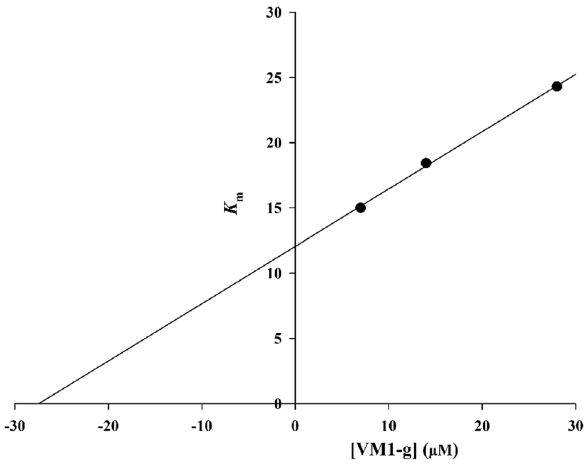
Figure 4. The secondary plot between K m and various concentrations of